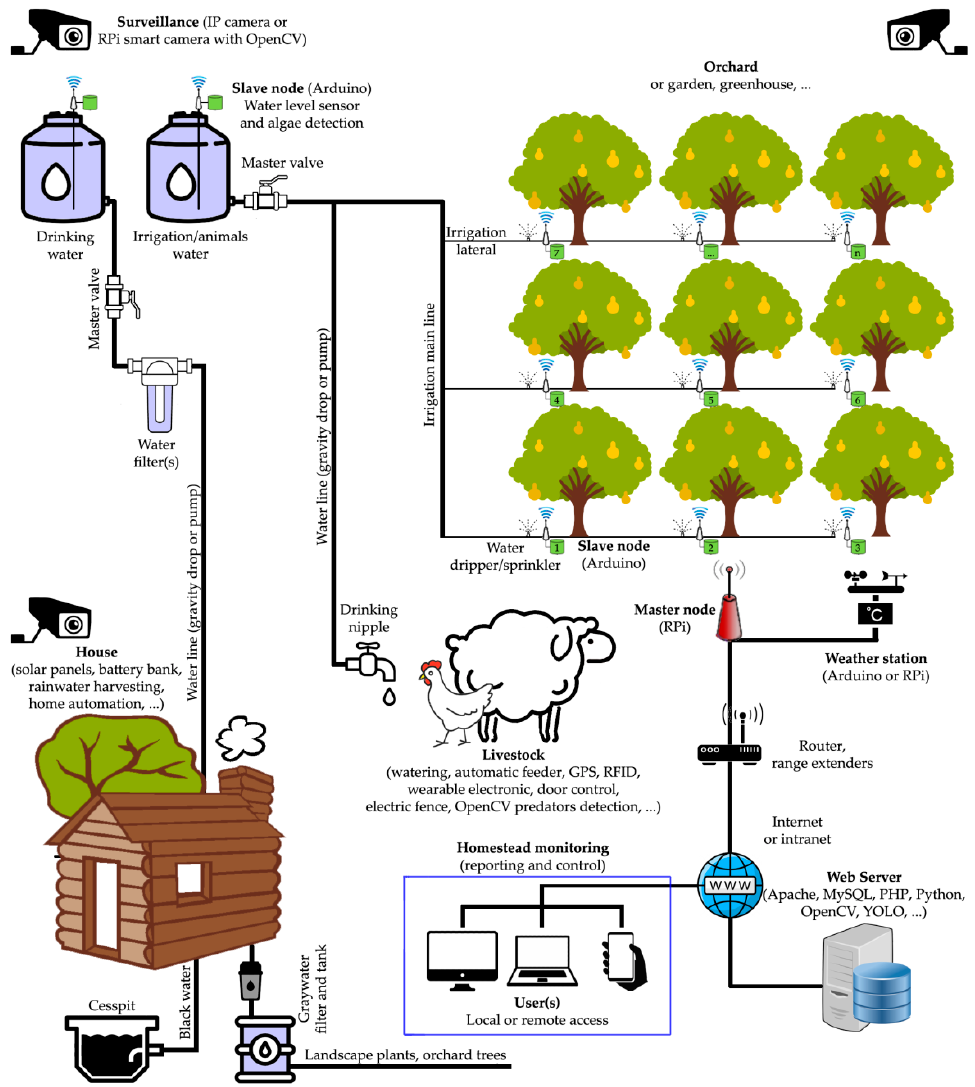
Figure 7. Integrated IoT based intelligent homestead automation system, high level overview.